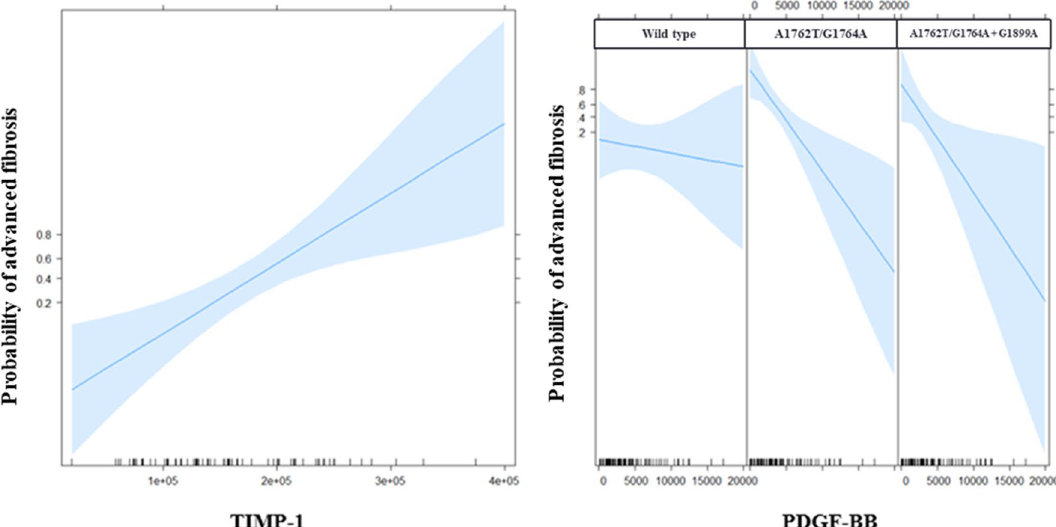
Figure 4. Effects of variables in the multivariate model of advanced fibrosis: TIMP-1 (left) and the interaction between PDGF-BB and the mutation profile (right) are on the X-axes; the probability of advanced fibrosis is on the Y-axes. The blue shades represent 95-percent pointwise confidence intervals around the estimated effects. The relationship between PDGF-BB and the probability of advanced fibrosis is steeper (slope of the curve) for individuals infected with viruses harboring BCP/PC mutations than for individuals infected with the wild